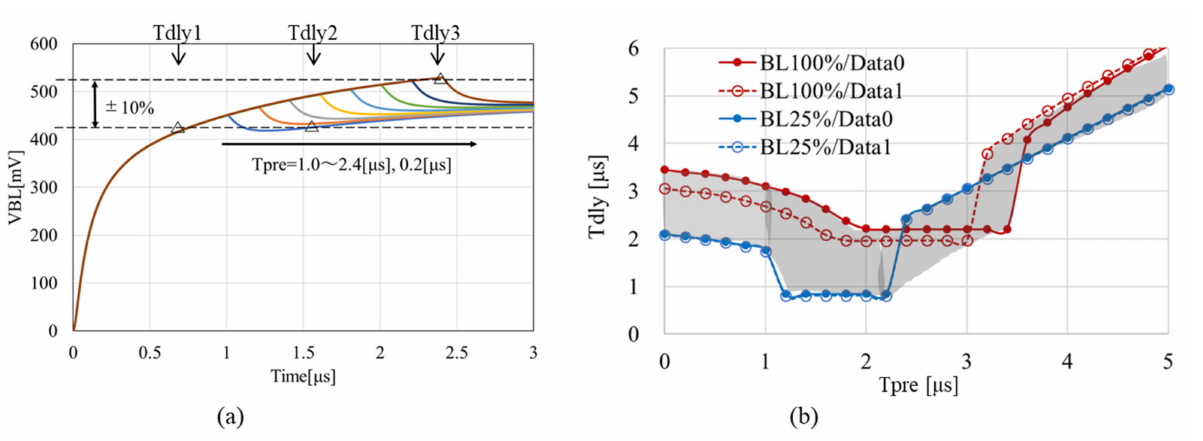
Figure 3. ( a ) BL voltage waveform with different PE pulse widths when the “0” cell at 25% of the BL is selected. ( b ) Delay time vs. PE pulse width.